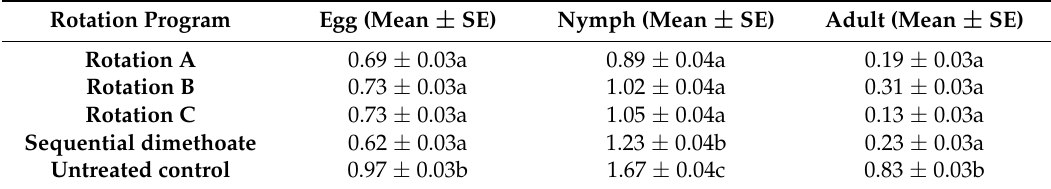
Table 4. Average density ranking ( ± SE) of Asian citrus psyllid, Diaphorina citri , egg, nymph, and adult counts during rotation treatments (31 May 2016 to 26 October